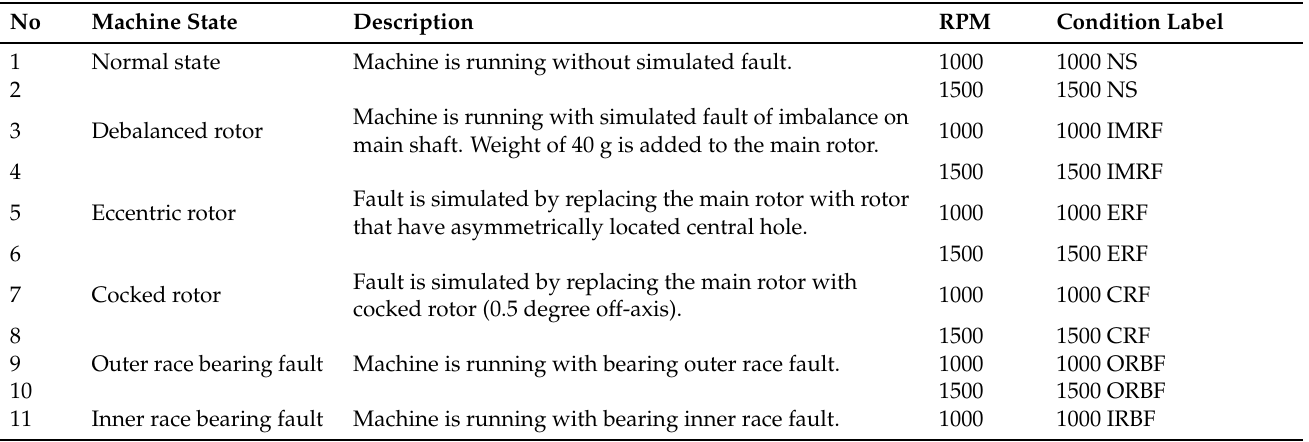
Figure 2. Fault simulator (1. Frequency drive Lenze SMVector; 2. Tachometer display, 3. Motor, 4. Clutch, 5. Front-end bearing, 6. Main shaft, 7. Load, 8. Main rotor, 9. Back-end bearing, 10. Three-axis IEPE accelerometer, 11. Horizontal axis alignment screw, 12. Vertical axis alignment screw, 13. Base, 14. BNC connectors). Table 1. Simulated fault conditions and